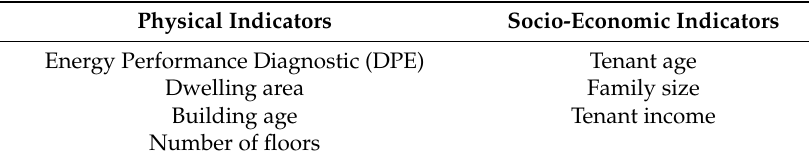
Table 1. Indicators used in the analysis of heating expenses in social